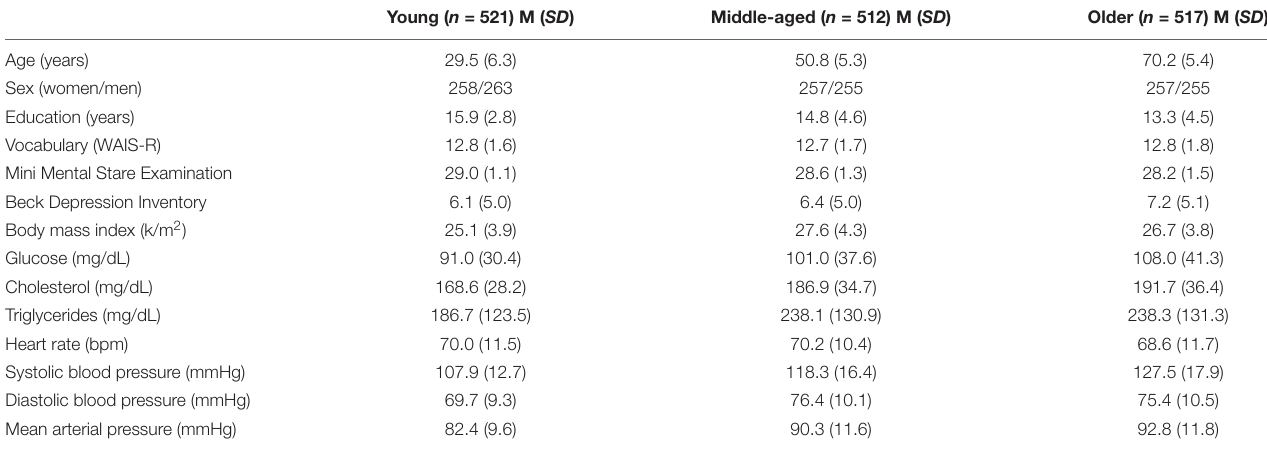
TABLE 1 | Participant characteristics and scores on neuropsychological tests in the three age